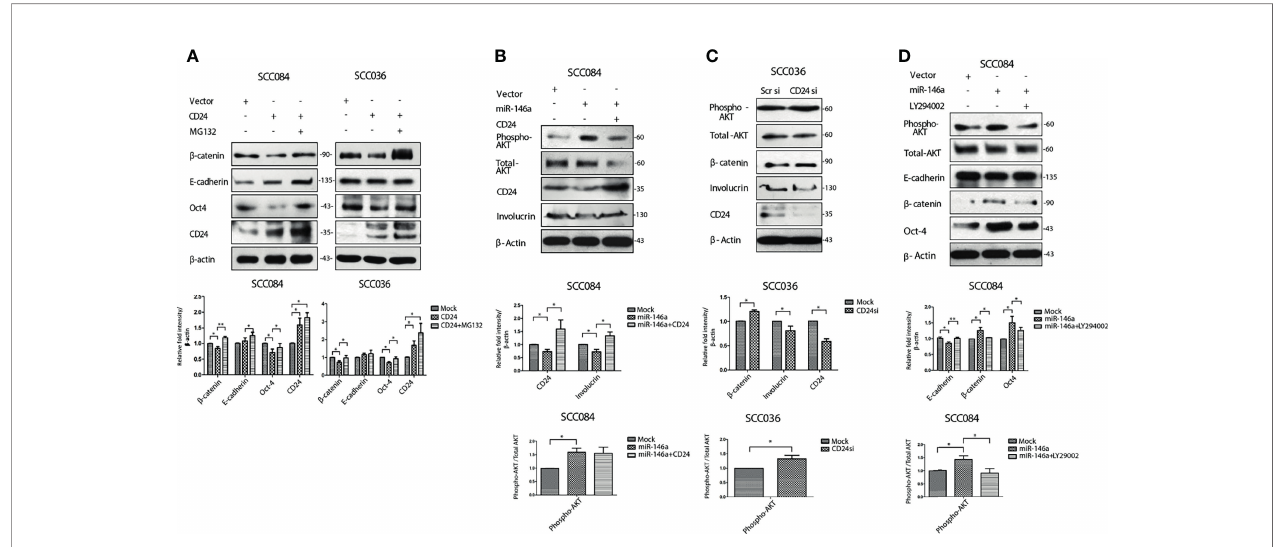
FIGURE 6 | MiR-146a leads to AKT mediated stabilization of b -catenin. (A) Western blot analysis revealed degradation of b -catenin upon CD24 over-expression revived with MG132 treatment in SCC084, SCC036. (B) Phospho-AKT levels upon ectopic expression of miR-146a alone or in combination with CD24. Total AKT is also shown. (C) Phospho-AKT and Total AKT levels upon siRNA mediated down-regulation of CD24 in SCC036 cells. (D) Effect of pAKT inhibitor (LY294002) on b - catenin levels in SCC084 cells. Histograms showing fold change in the densitometric values of band intensity is represented as avg ± S.D. of n different experiments (n = 3) (*P < 0.05, **P <